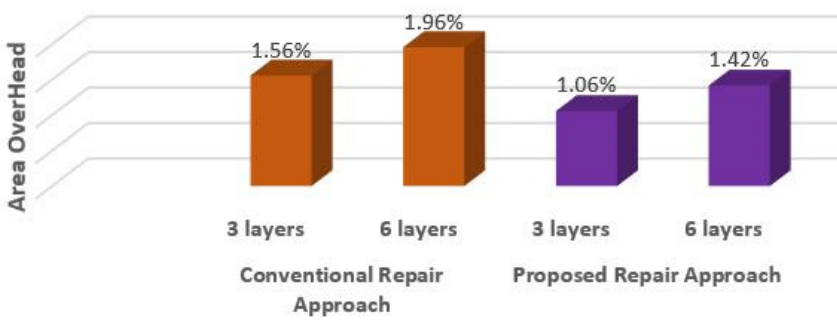
Figure 16. Comparison between proposed Vs Conventional TSV BIST area overheads . Table 3. Area Overhead comparison.